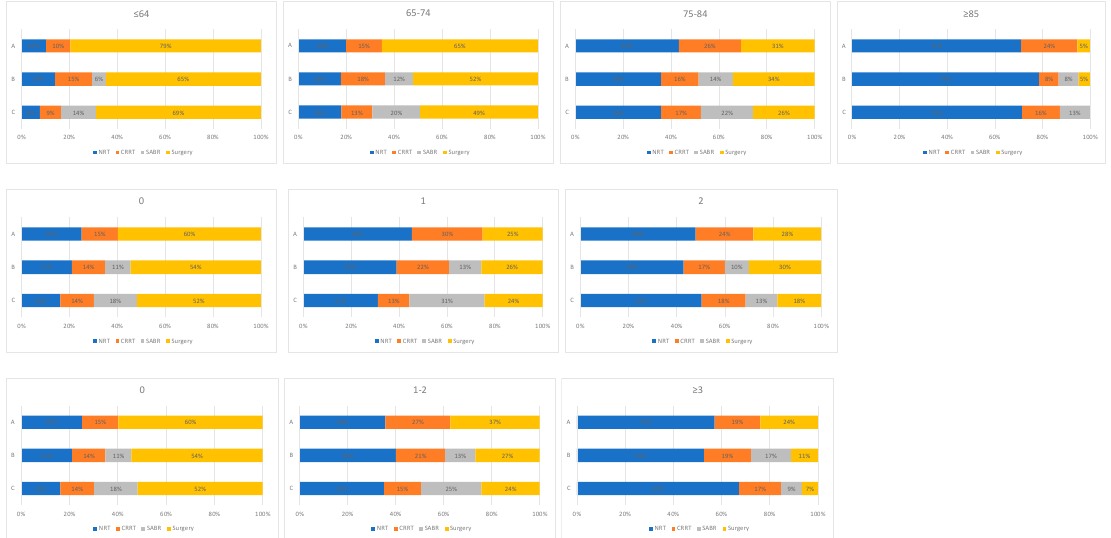
Figure 4. Treatment utilisation for all patients with stage I NSCLC by time period and A: age, B: performance status, C: Charlson comorbidity index subgroups. (A: 2012-2103, Pre-SABR, B: 2104-2106, Introduction of SABR, C: 2017-2019, SABR Established).